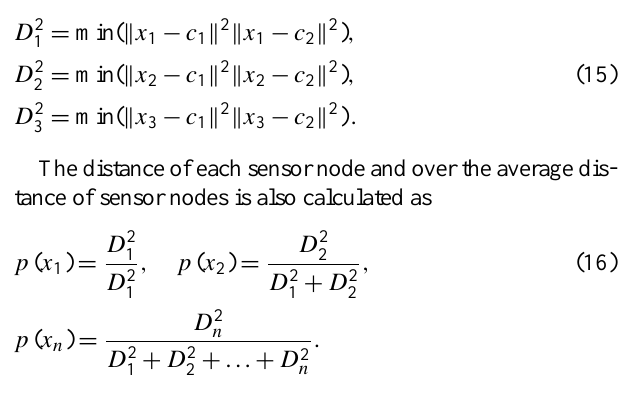
Figure 2. k-means algorithm diagram: a) location of the sensor nodes; b) initial centers; c) new center after multiple iterations; Figure 2. k -means algorithm diagram: (a) location of the sensor nodes; (b) initial centers; (c) new center after multiple